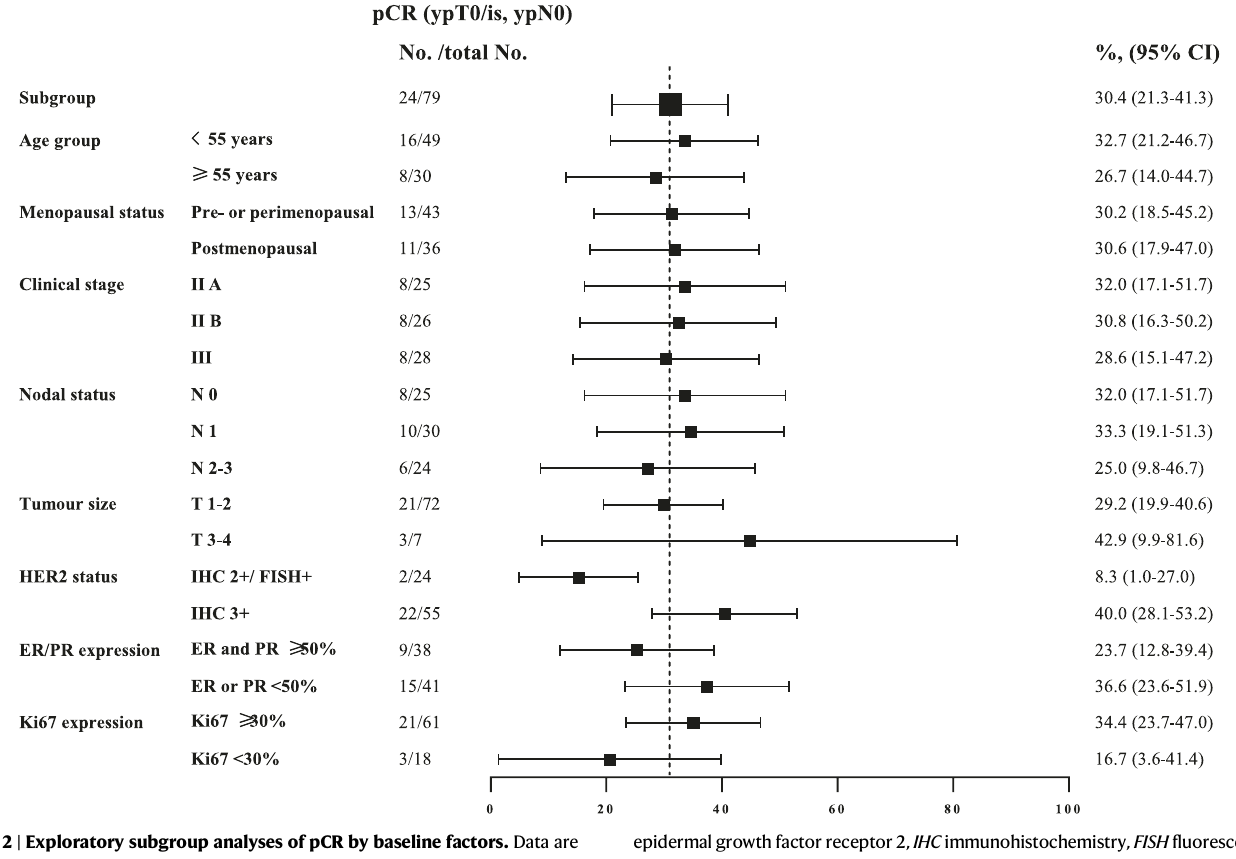
Fig. 2 | Exploratory subgroup analyses of pCR by baseline factors. Data are presented as pCR rate (%) and 95% CI. The black squares indicate the pCR rates following strati fi cations. pCR pathological complete response, HER2 human